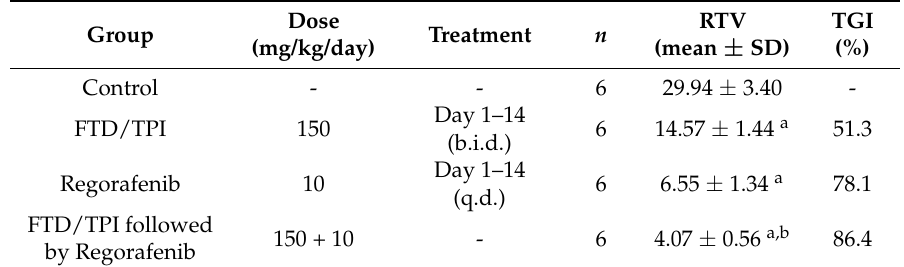
Table 1. Anti-tumor effects of trifluridine/tipiracil (FTD/TPI) and regorafenib in mice implanted with SW620 human colorectal